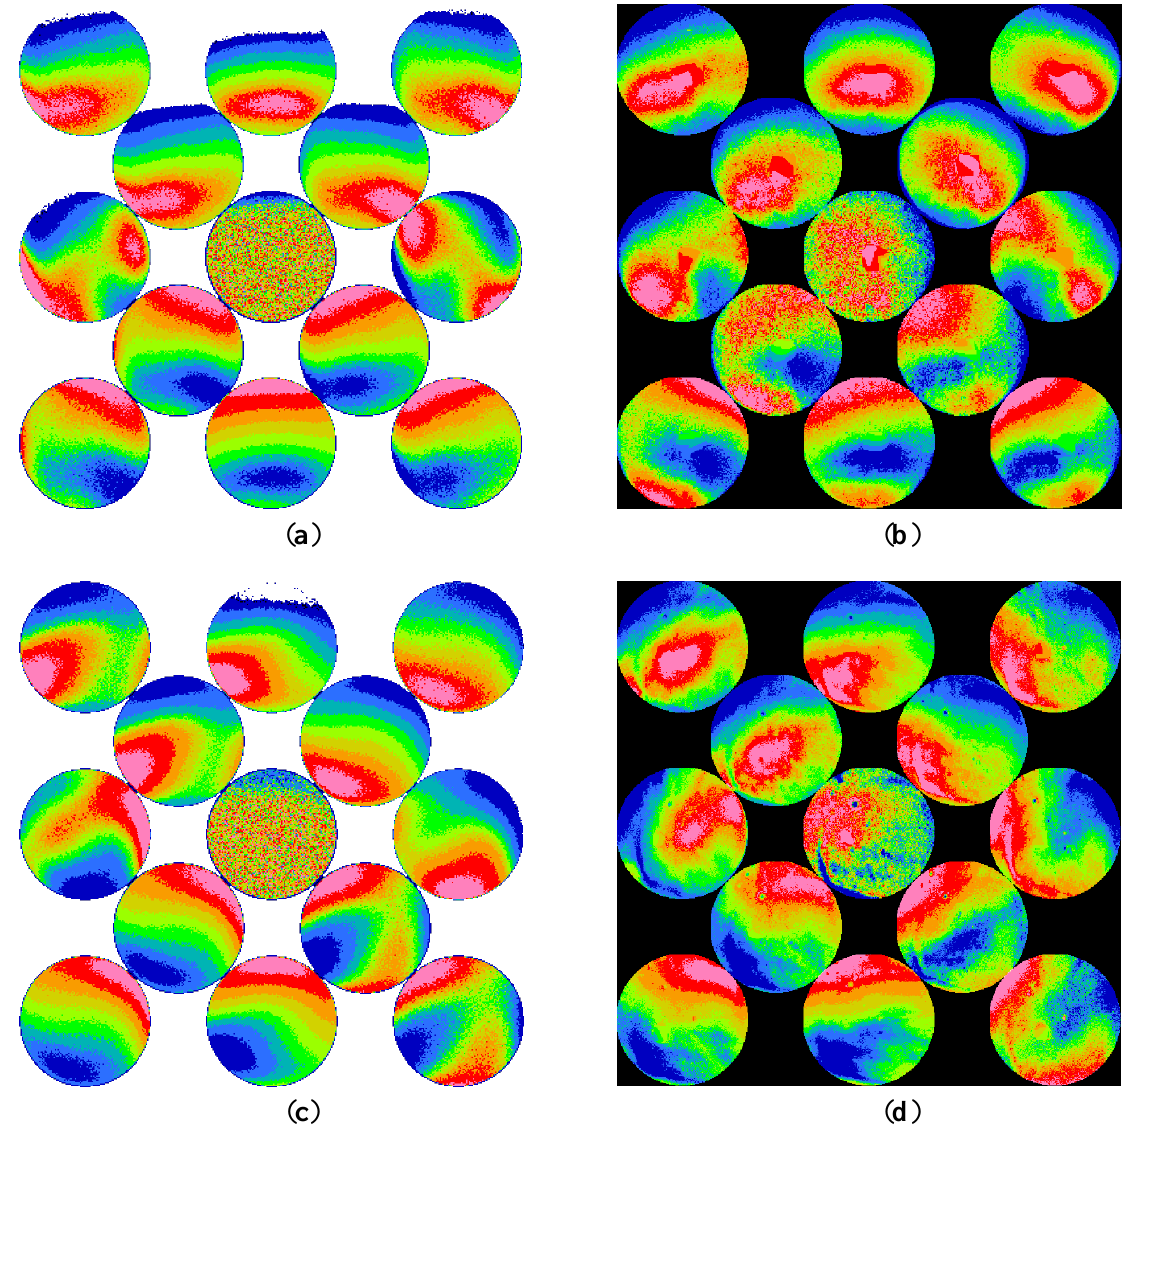
Figure 10. ( a ) Computer simulation result of infrared retinoscopy measurement on a 28 year-old keratoconus eye using a paraxial eye model with the customer wavefront data. The manifest refraction of this eye was measured as −0.50DS + 3.25DCX155 (20/25). The pupil diameter of the wavefront data is 4.25 mm. Two diopters of accommodation was assumed in the computation. ( b ) The experimental-measured image of the same eye. The pupil diameter is about 4.5 mm in this measurement. ( c ) Computation result of a 35 year-old keratoconus eye. The manifest refraction was measured as −3.25DS + 3.00DCX10 (20/25-). The pupil diameter of the wavefront data is 6 mm, and 2.1 diopters of accommodation was assumed in this computation. ( d ) The experimental-measured image of the same eye. The pupil diameter is about 6.9 mm in this